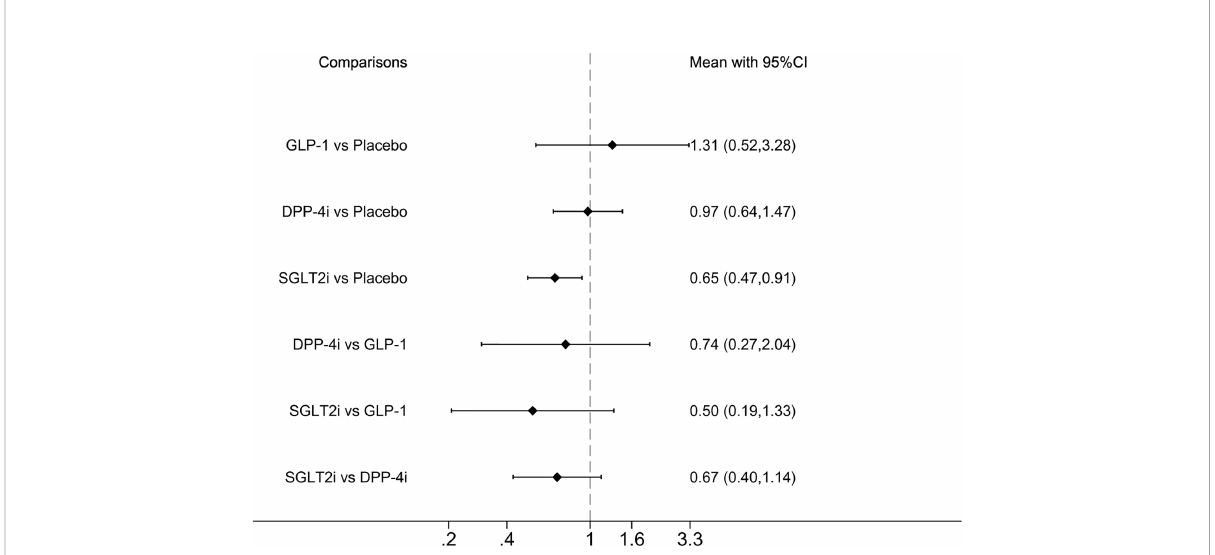
FIGURE 2 Forest plot of odds ratio comparing the serious adverse events between each medicine class or between each medicine class and